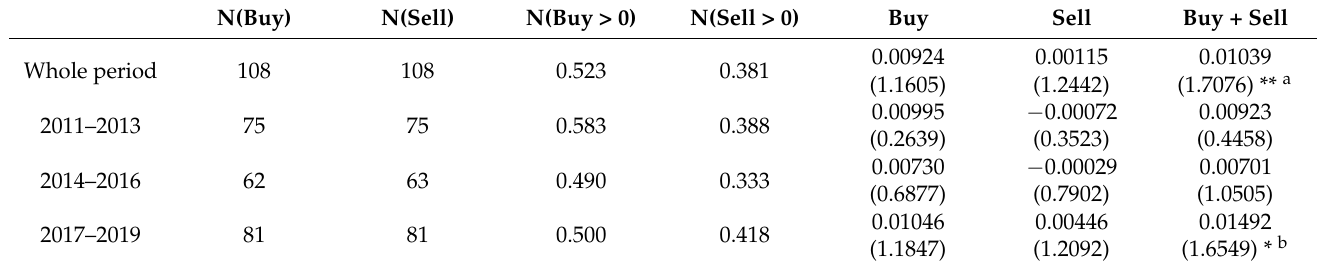
Table 8. t -test Output for the MACD (4,22,3) Model with the minimum ‘1-day’ Holding Strategy. vs. the MACD (12,26,9)